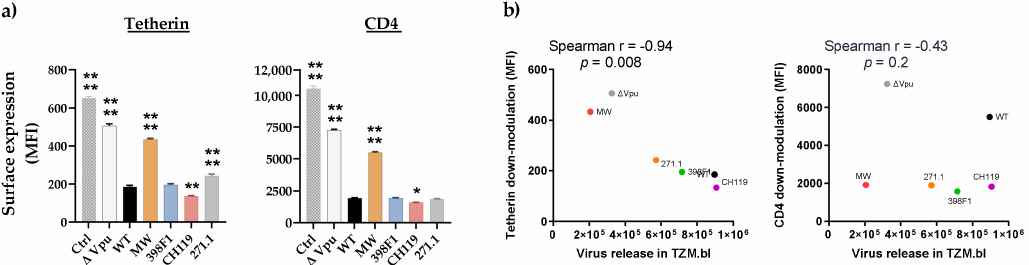
Figure 4. Down modulation of tetherin and CD4. ( a ) TZM.bl cells expressing endogenous tetherin and CD4 were transfected with CMU06 proviral plasmids expressing chimeric Vpu and Env. Cells were analyzed for tetherin and CD4 expression 48h post-transfection by flow cytometry. Median fluorescent intensity (MFI) + SD values of triplicates from representative experiment are